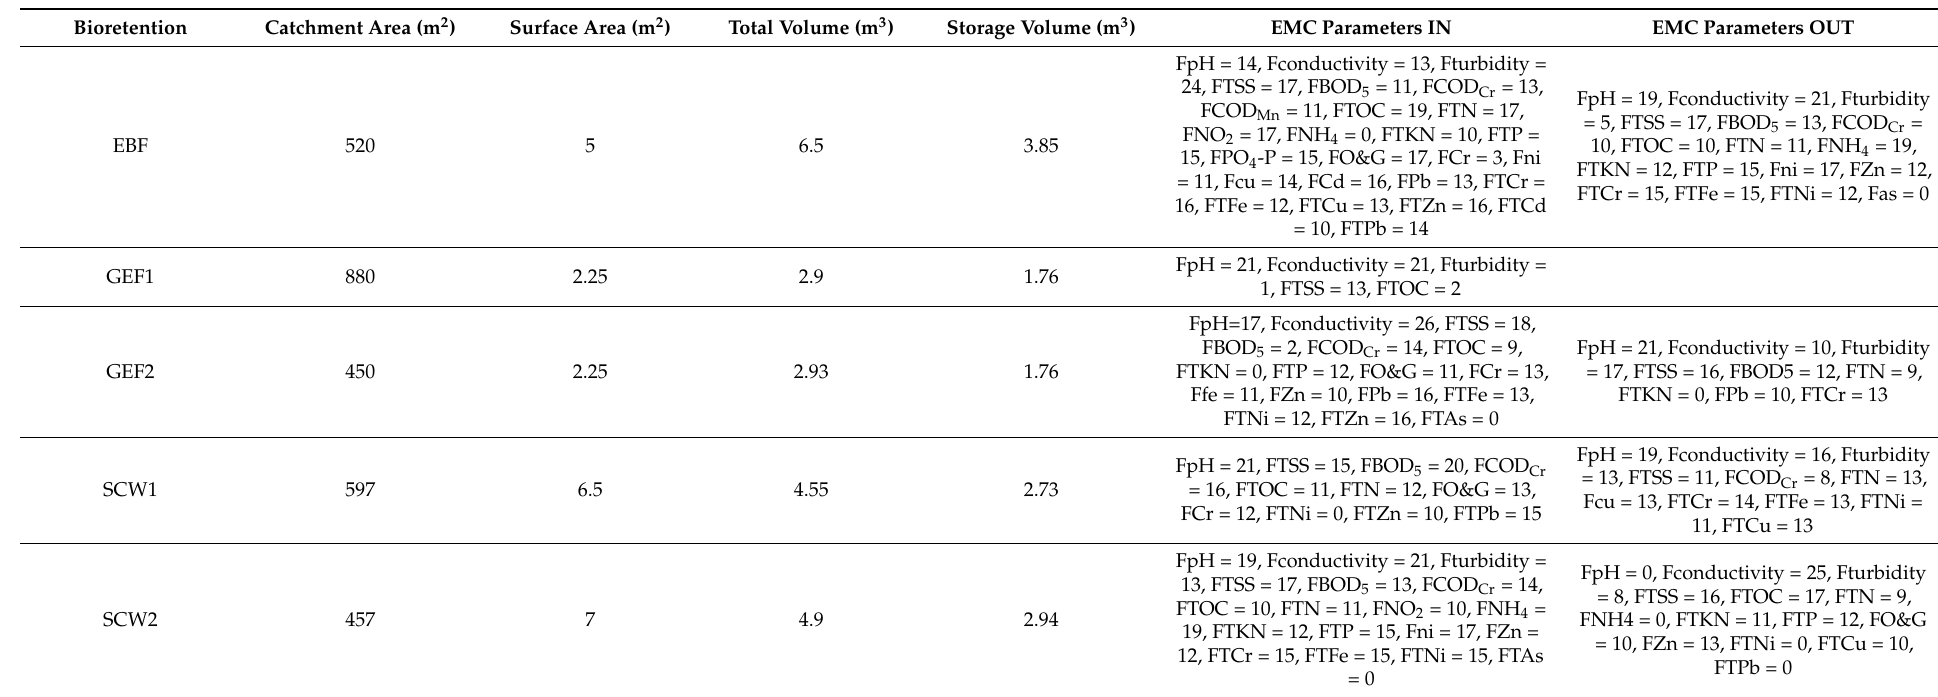
Table 8. Critical fuzzified parameters present before and after